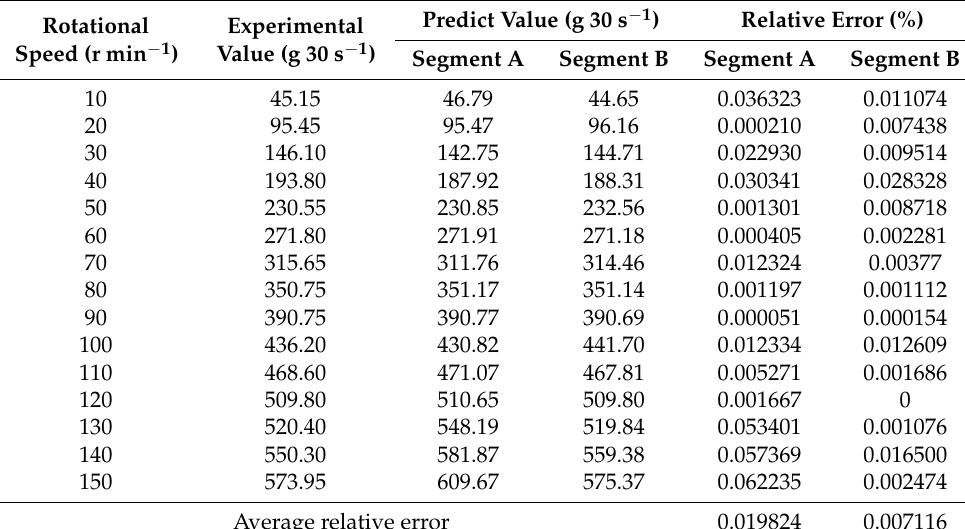
Table 7. Comparison of the prediction accuracies at the opening length of 8 mm.